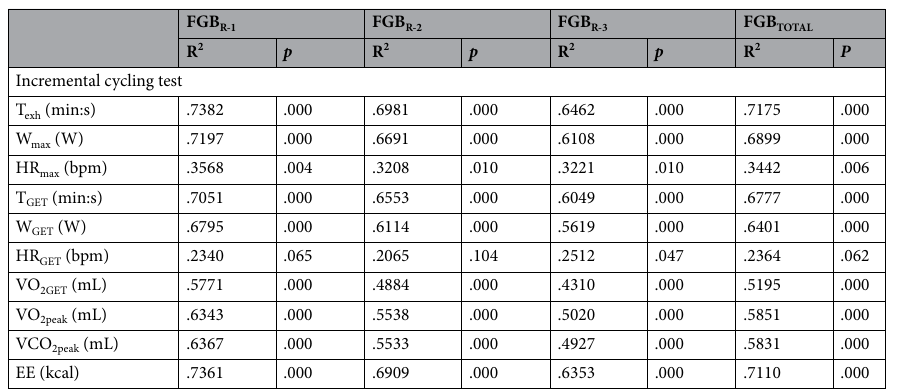
Table 5. Correlations between Fight Gone Bad performance and aerobic capacity. EE, energy expenditure; FGB R-1 , Fight Gone Bad Round 1; FGB R-2 , Fight Gone Bad Round 2; FGB R-3 , Fight Gone Bad Round 3; FGB TOTAL , Fight Gone Bad total number of repetitions; HR GET , heart rate at gas exchange threshold; HR max , maximal heart rate; T exh , time to exhaustion; T GET , time to gas exchange threshold; VCO 2peak , maximal carbon dioxide production;